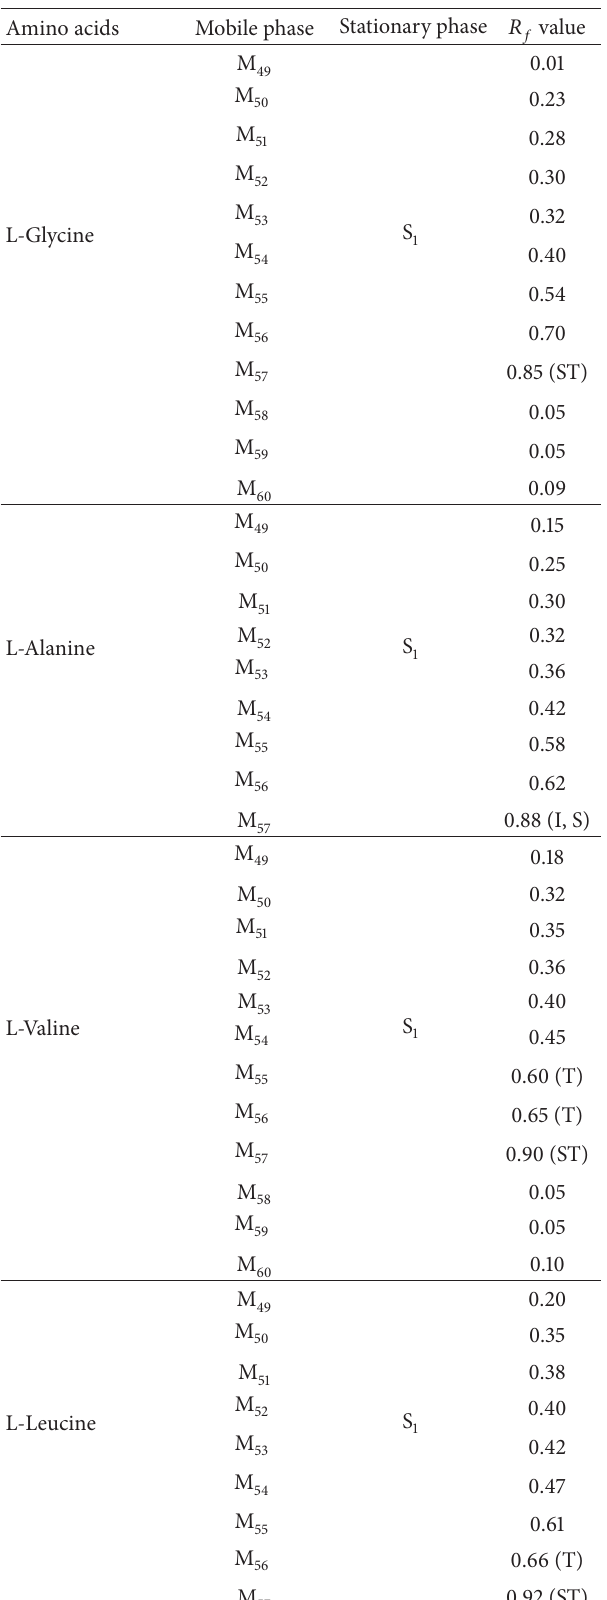
Table 5: 𝑅 𝑓 value of amino acids in microemulsion containing solvent systems: data is extracted from references [15,